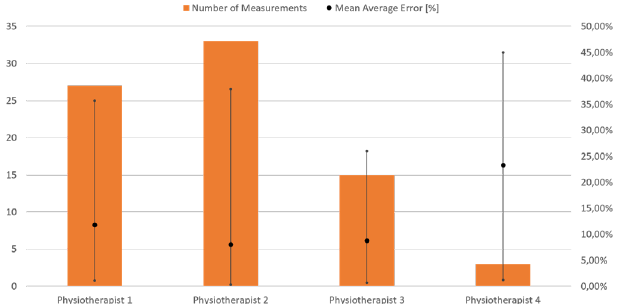
Figure 2. Number of measurements per physiotherapist. The black lines indicate the corresponding error range and the mean average error between the manual measurement and ground truth.